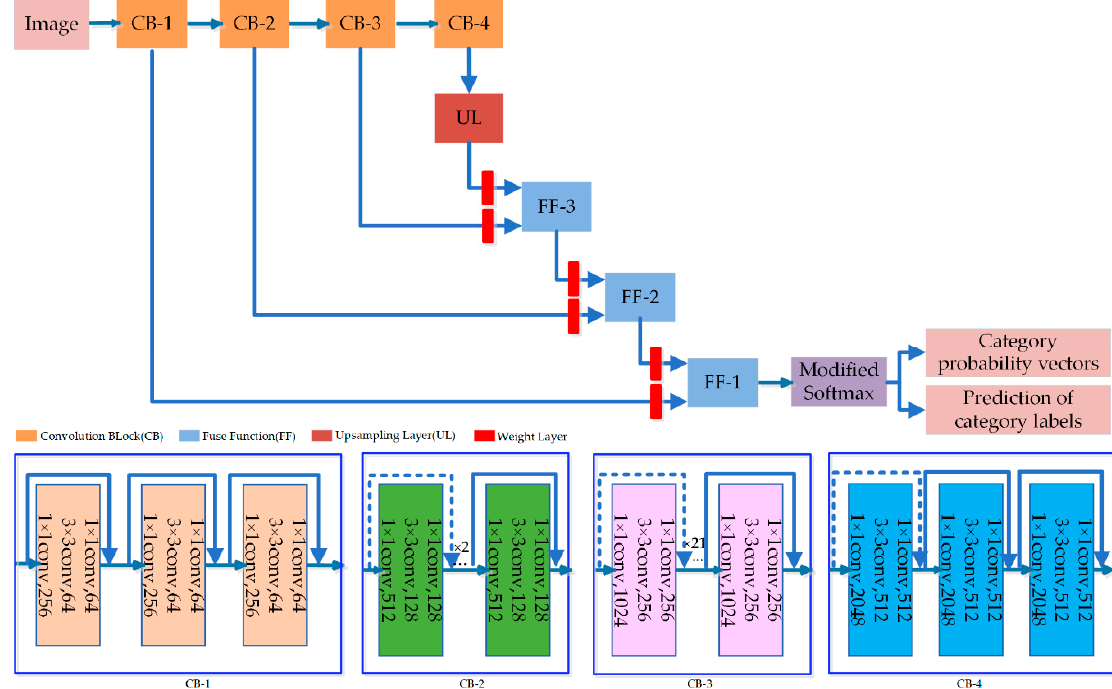
Figure 4. Structure of the improved RefineNet model used in this study. CB: Convolution Block; FF: Fuse Function; UL: Upsampling Layer